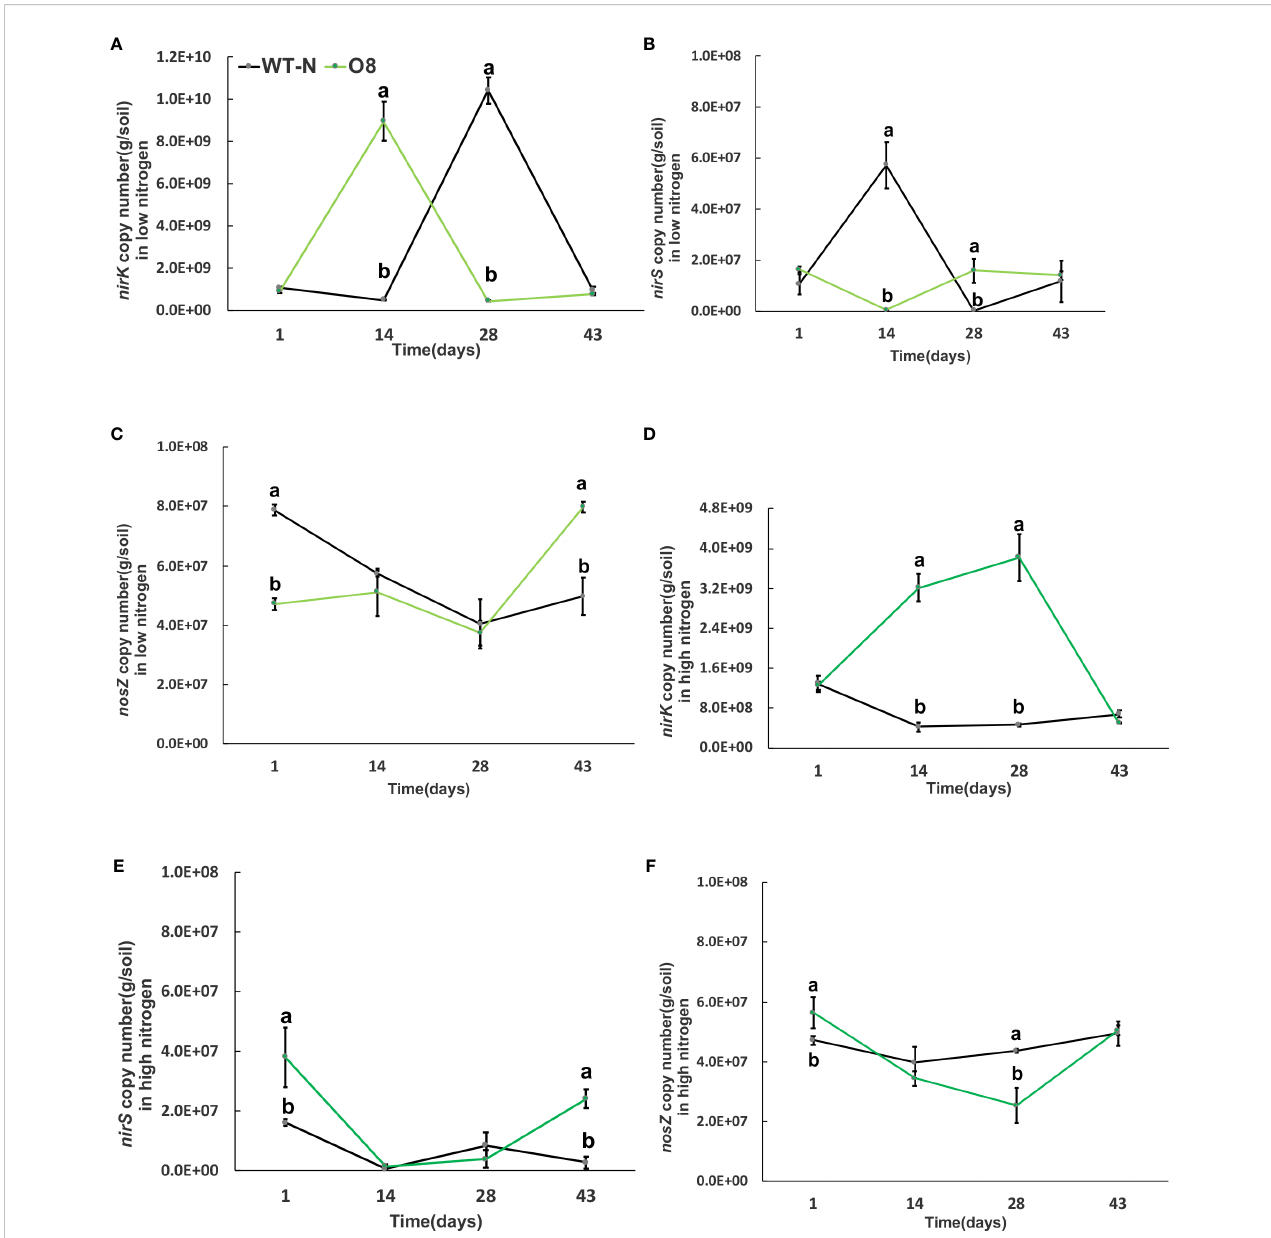
FIGURE 9 The abundance of nirK, nirS and nosZ genes in low and high Nitrogen soil of WT-N and O8. X-axis shows the soil sampling time (days), from the fi rst measurement after transplanting seedlings from nursery to fi eld. Figures (A, D) show the nirK copy number/g of soil in low and high nitrogen application. Figures (B, E) show the nirS copy number/g of soil in low and high nitrogen application. Figures (C, F) show the nosZ copy number/g of soil in low and high nitrogen application Error bars: SE (n = 3). Signi fi cant difference between WT and O8 are indicated by different letters: a= high value, b= lower value ( t -test, p<